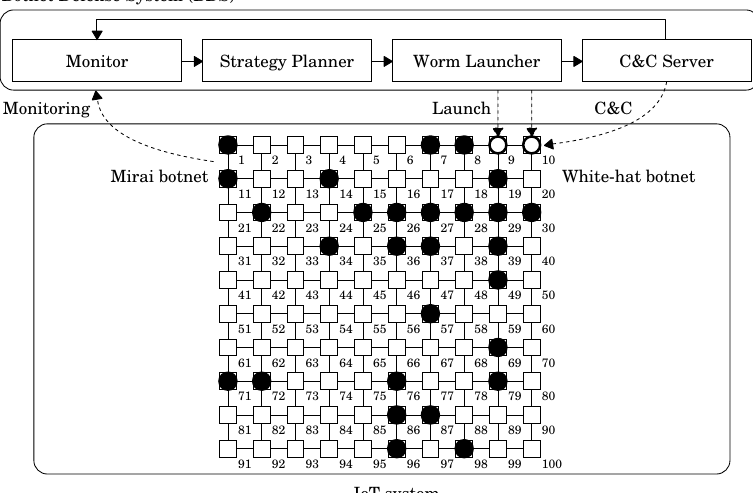
Figure 1. The overview of the Botnet Defense